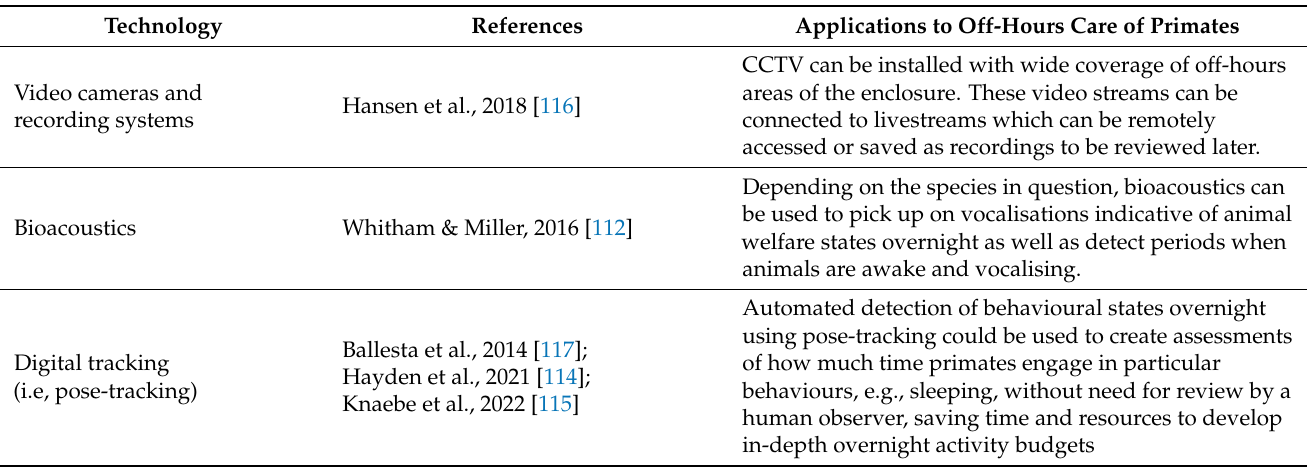
Table 2. Overview of monitoring technologies available and their applications to the off-hours care of